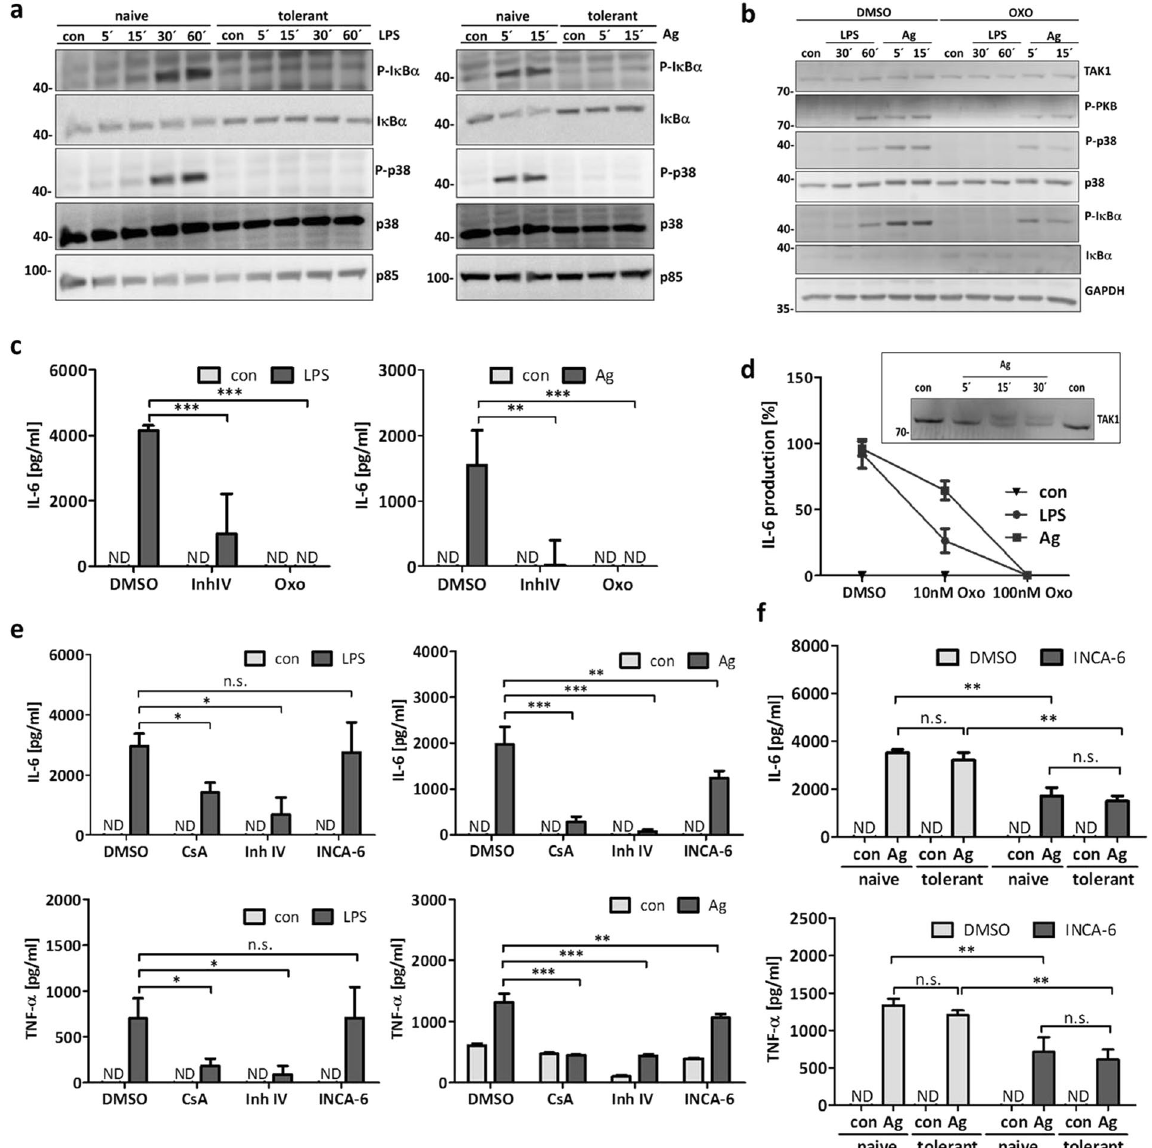
Figure 6. Differential activation of signalling pathways in tolerant cells in response to antigen stimulation. To induce ET, BMMCs were treated with LPS (300 ng/ml) for 24 h and loaded with IgE (150 ng/ml) overnight. Naive and tolerant cells were stimulated with LPS (1 µ g/ml) or Ag (DNP-HSA; 20 ng/ml) for indicated times. Immunoblotting against P-I κ B α , I κ B α , P-p38, p38 and p85 (loading control) was performed ( a ). Additionally, cells were incubated with the TAK1 inhibitor (5Z)-7-Oxozeaenol (Oxo; 300 nM) for 30 min and stimulated with LPS or Ag for indicated times. Subsequently, Western blotting was performed with antibodies against TAK1, P-PKB, P-I κ B α , I κ B α , P-p38, p38 and GAPDH (loading control) ( b ). Western Blots are representative of three independent experiments. Furthermore, BMMCs were incubated with Oxo (300 nM) for 30 min and stimulated with LPS or Ag for 4 h to analyse IL-6 production ( c ). Data show mean ± SD from n = 3 independent experiments. Two-sided ANOVA with Dunnet’s post-hoc test was performed to calculate p-values. To analyse the differential effect of Oxo on IL-6 production, BMMCs were treated with 10 nM and 100 nM Oxo and then left unstimulated (con) or stimulated with LPS and Ag for 4 h ( d ). Data show mean ± range from n = 2 independent experiments each measured in triplicates. Moreover, IgE-preloaded BMMCs were left unstimulated (con) or stimulated with Ag for indicated times and TAK1 was detected by Western blotting; shown in the insert to ( d ). Furthermore, BMMCs were treated with Cyclosporin A (CsA; 0.1 µ M), IKK- β inhibitor InhIV (3 µ M), and INCA-6 (3 µ M) for 1 h and then stimulated with LPS and Ag for 4 h to measure IL-6 and TNF- α secretion ( e ). Data show mean ± SD from n = 3 independent experiments. Two-sided ANOVA with Dunnet’s post-hoc test was performed to calculate p-values. Tolerant and naive BMMCs were incubated with INCA-6 (3 µ M) for 1 h and stimulated with Ag for 4 h to measure IL-6 and TNF- α production ( f ). Data show mean ± SD from n = 3 independent experiments. Student’s t -Test was performed to calculate p-values. * p < 0.05, ** p < 0.01, *** p <